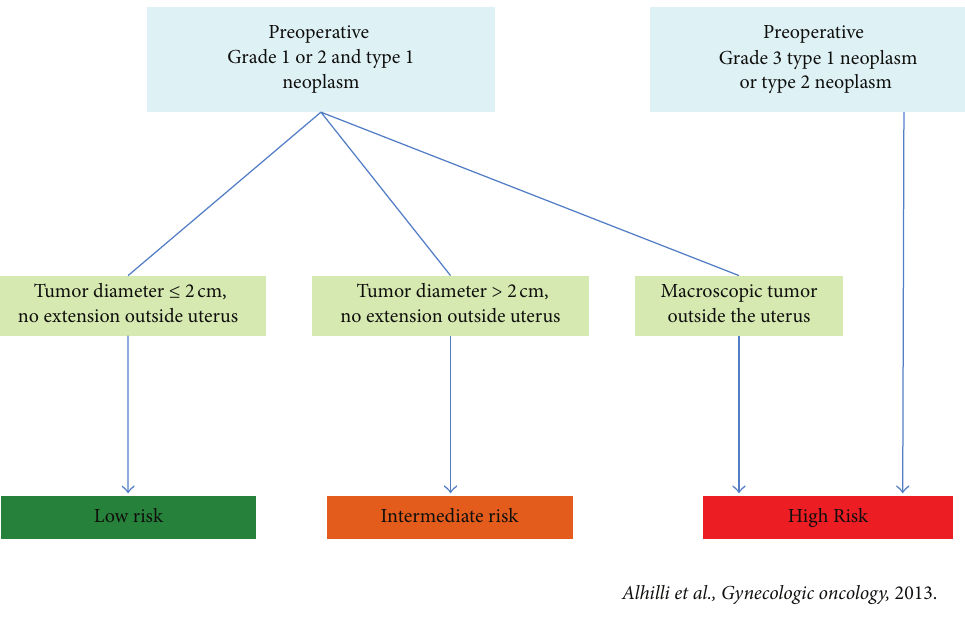
Figure 1: Stratification into risk categories.